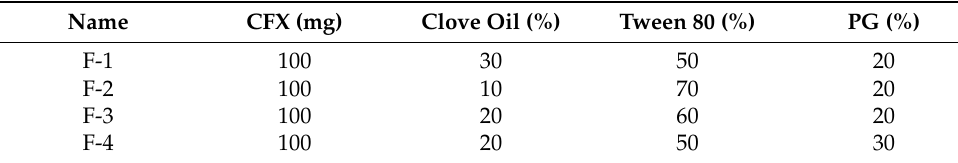
Table 2. Composition of optimized SEDDS formulations.